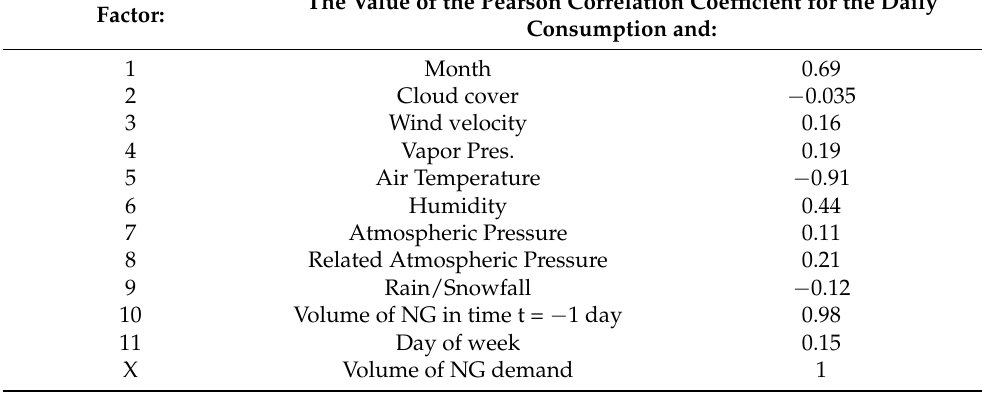
Table 1. Pearson correlation coefficient for individual data types and daily consumption. The Value of the Pearson Correlation Coefficient for the Factor: